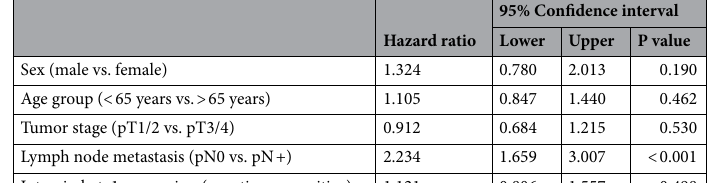
95% Confidence interval Hazard ratio Lower Upper P